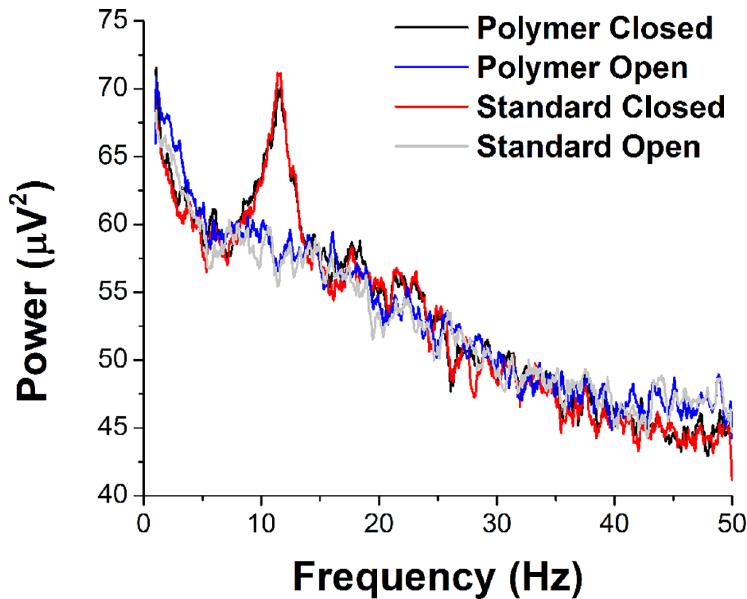
Fig 7. Spectral power for conditions of eyes-open and eyes-closed for a sample subject using CNF-PDMS and standard Ag-AgCl electrodes. Note close correspondence with the typical peak in the alpha (8–14 Hz) band during eyes-closed conditions for both CNF-PDMS (black) and Ag-AgCl